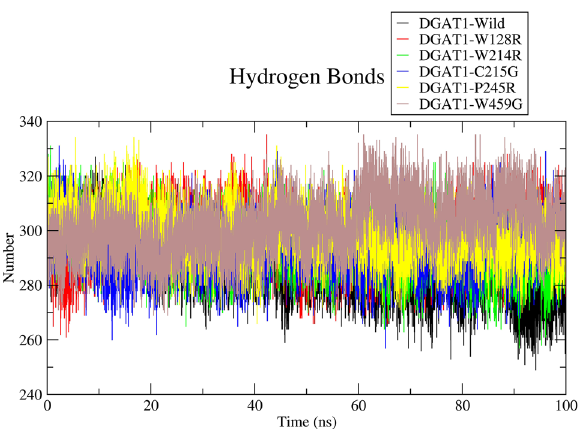
Figure 6. Intramolecular hydrogen bonds calculation illustrated as a time-dependent change. DGAT-Wild (black), DGAT1-W128R (red), DGAT1-W214R (green), DGAT1-C215G (blue), DGAT1-P245R (yellow), and DGAT1-W459G